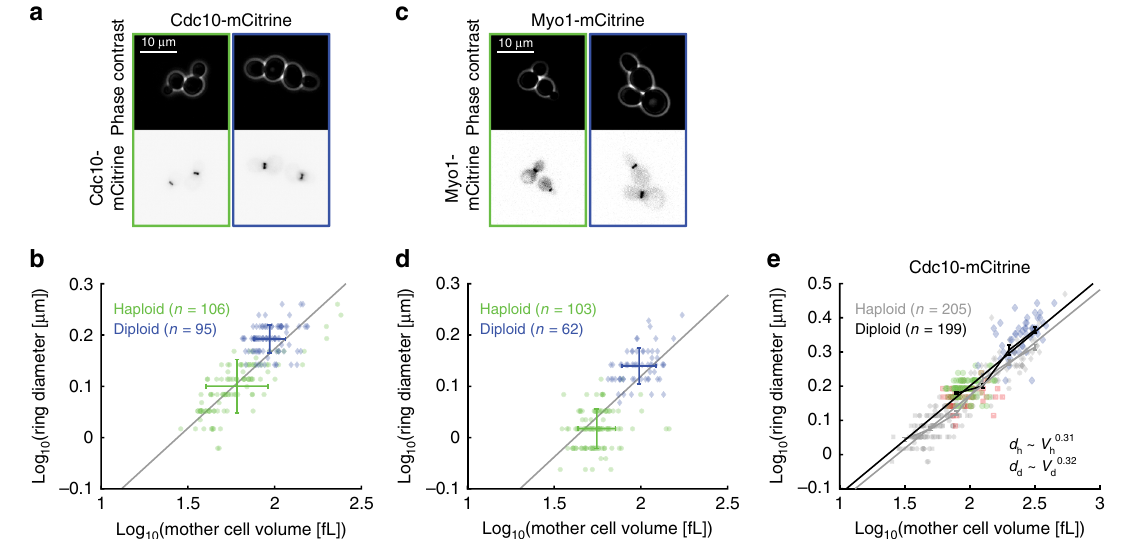
Fig. 5 Cell volume explains larger ring diameter in diploids. The ring diameter as obtained from mCitrine-tagged Cdc10 ( a , b ) and Myo1 ( c , d ) is larger in diploid cells (blue, diamonds) compared with haploids (green, circles). a , c Representative live-cell microscopy images of haploid (left) and diploid (right) cells are shown (phase contrast (top) and mCitrine fl uorescence (bottom)). b , d For each cell, the median ring diameter during the time when the ring is detected is shown as a function of the median cell volume during that time. Error bars denote mean and standard deviation for haploids (green) and diploids (blue). Gray lines show linear fi ts obtained in Fig. 2 for haploids of different sizes for comparison. 106 (Cdc10-mCitrine) and 103 (Myo1-mCitrine) haploid cells, each pooled from three independent experiments. 95 (Cdc10-mCitrine) and 62 (Myo1-mCitrine) diploid cells, each pooled from two independent experiments. e In addition to wild type (green, circles), a diploid strain carrying a β -estradiol-inducible WHI5 allele was used to obtain steady- state cell populations of small (0 nM β -estradiol: red, squares) and large (60 nM β -estradiol: blue, diamonds) volumes. Data for haploid cells from Fig. 2 are shown for comparison (gray symbols). Data for each ploidy are pooled (205 haploid cells pooled from six independent experiments; 199 diploid cells pooled from four independent experiments) and linear fi ts to the double-logarithmic data as well as binned means with standard errors are shown (haploids in gray, diploids in black). Cells were grown on SCGE. Source data are provided as a Source Data fi